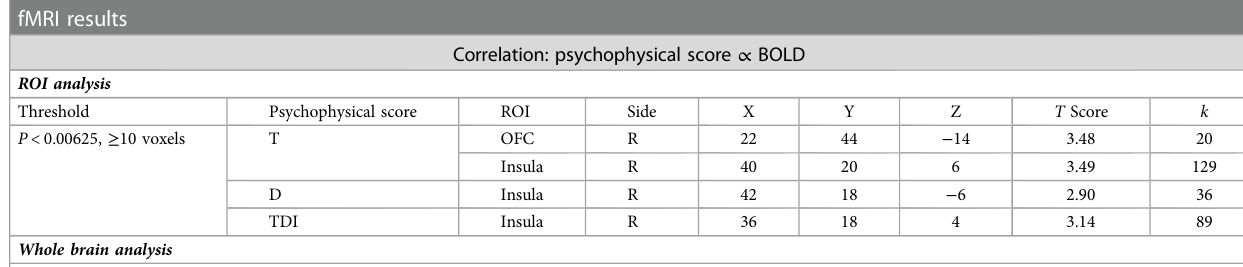
TABLE 5C Clusters of signi fi cant positive correlation between psychophysical test score and BOLD signal. fMRI results Correlation: psychophysical score ∝